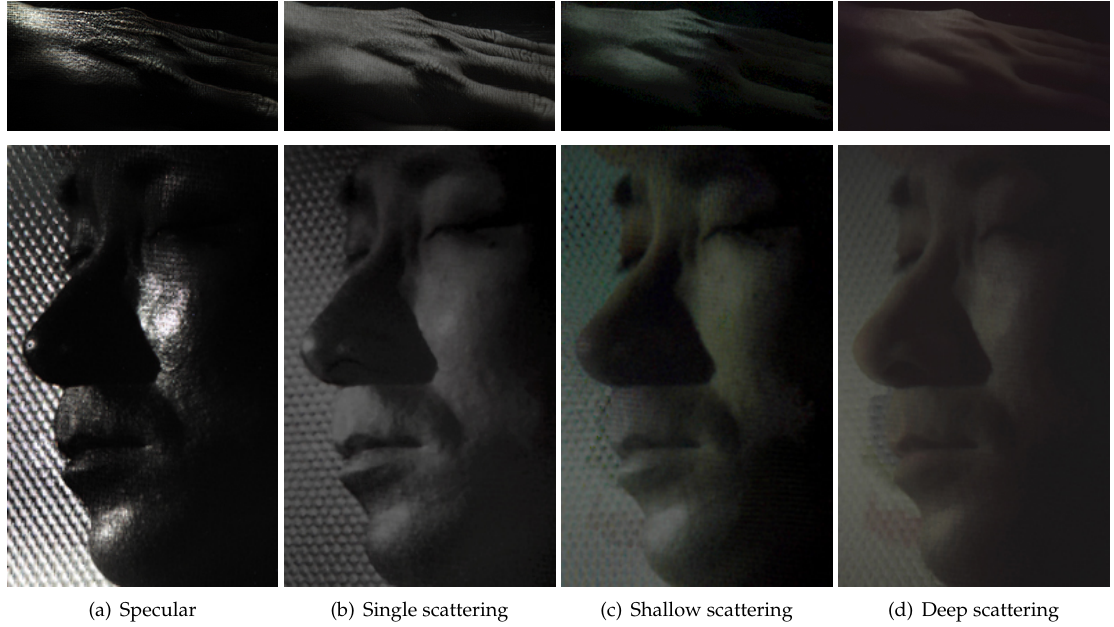
Figure 15. Layered reflectance separation over a hand and a face with single-shot FPLF imaging under